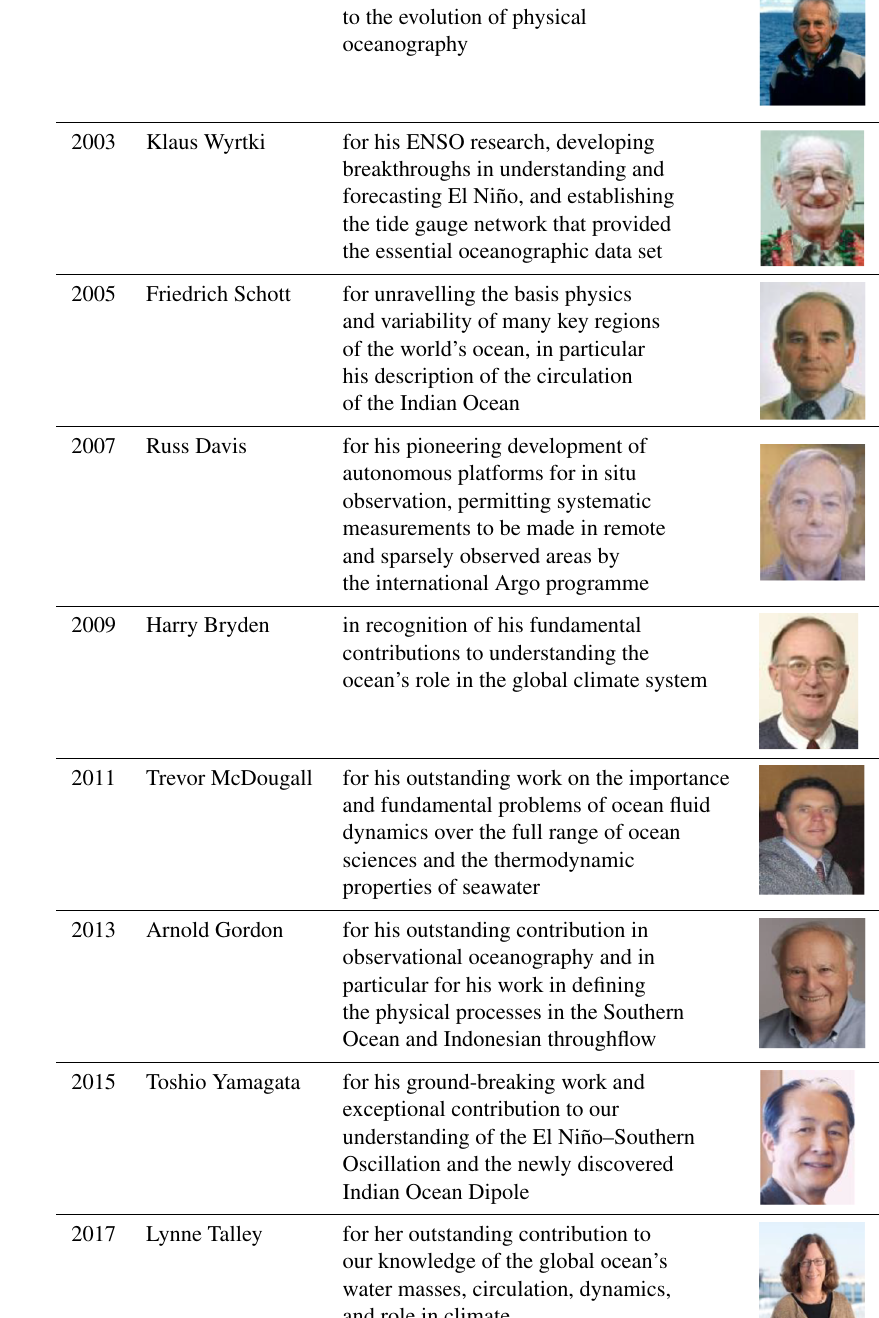
Table 2. The Prince Albert I Medal winners to date (source: IAPSO archives).